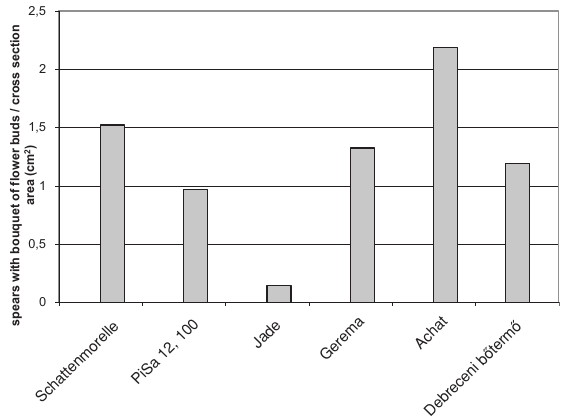
020406080100120140160 no i t ces ss o r c / ) m c ( h t gn e l t ooh s l a t oT a r ea ( c m 2 ) S c ha tt en m o r e ll e P i S a 12 , 100 J ade G e r e m a A c ha t D eb r e c en i bô t e r m ô Figure 1. Shoot length specified by the cross section area of the respective branch ( Debrecen-Pallag, 2010)